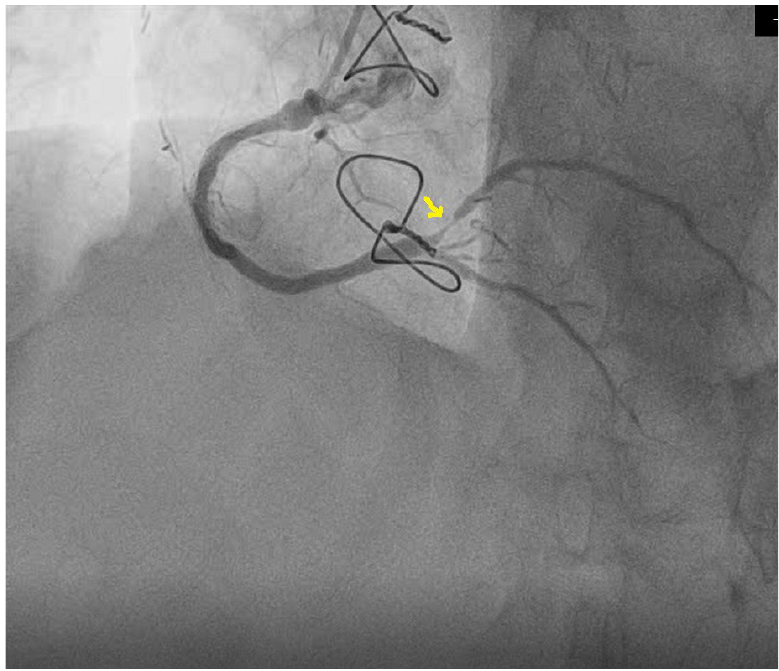
Figure 5. Sub-occlusive stenosis of the postero-lateral branch of the right coronary artery (arrow).